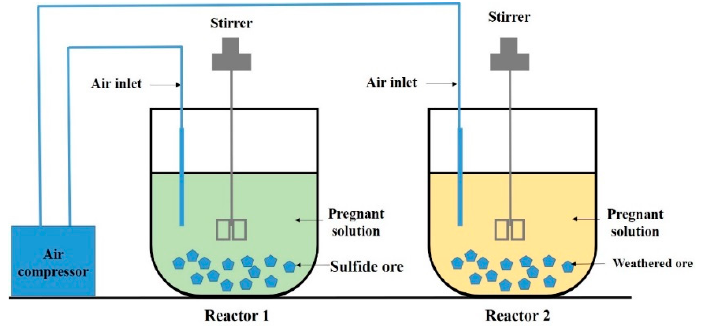
Figure 2. Stirred bioleaching reactors scheme.